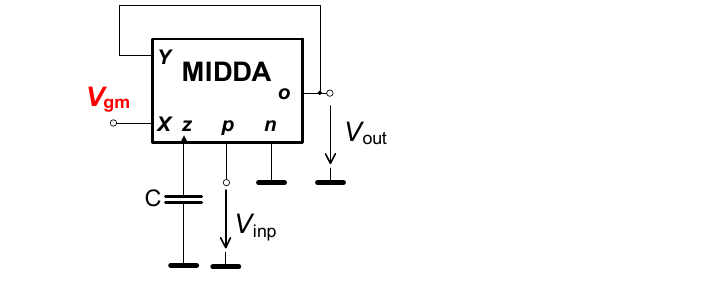
Figure 8. Simple application of a proposed MIDDA in a first-order high-pass filter with adjustable pole frequency.